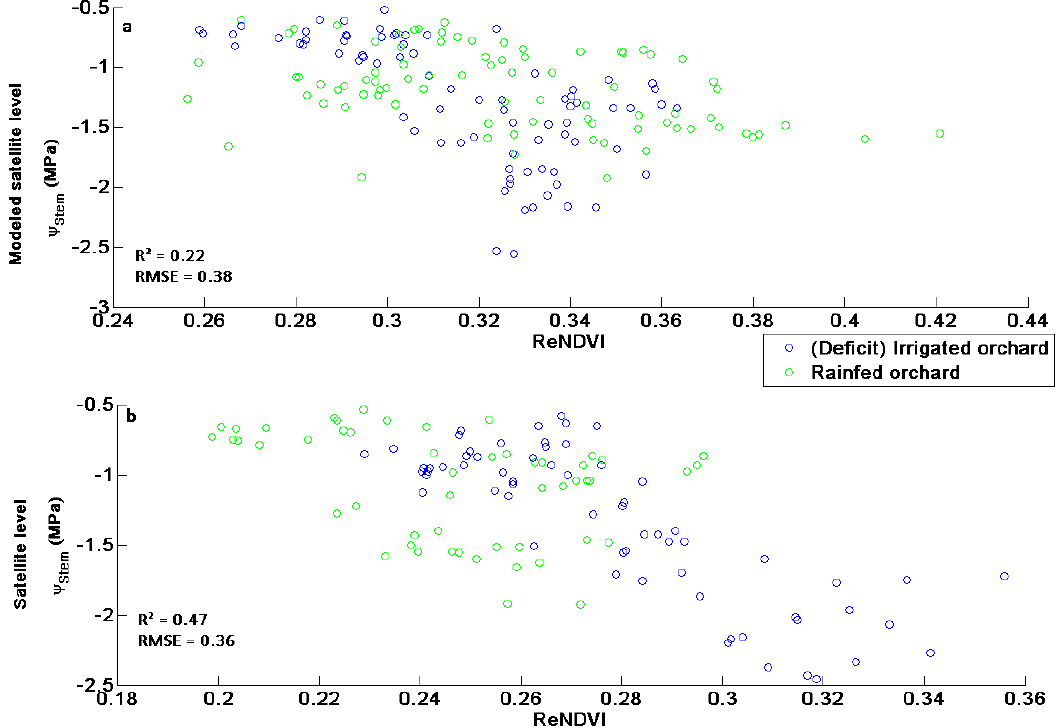
Figure 4. Scatter plot of Red edge Normalized Difference Vegetation Index (ReNDVI; Equation (4)) with measured stem water potential ( Ψ level ( a ) and the satellite level ( b ). All points were labeled for